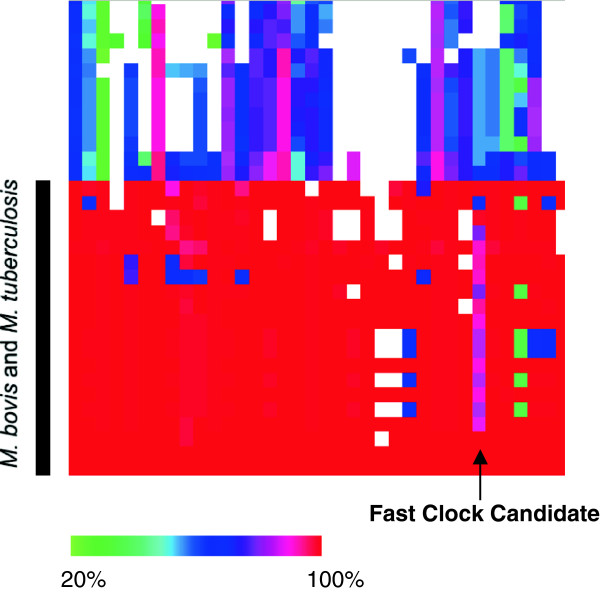
Use of CodaChrome to identify fast-clock genes. Enlargement of a region of a CodaChrome heat map with Mycobacterium tuberculosis H37Rv loaded as the seed sequence and with the PID threshold set to 20%. The rows were sorted by overall percent identity.